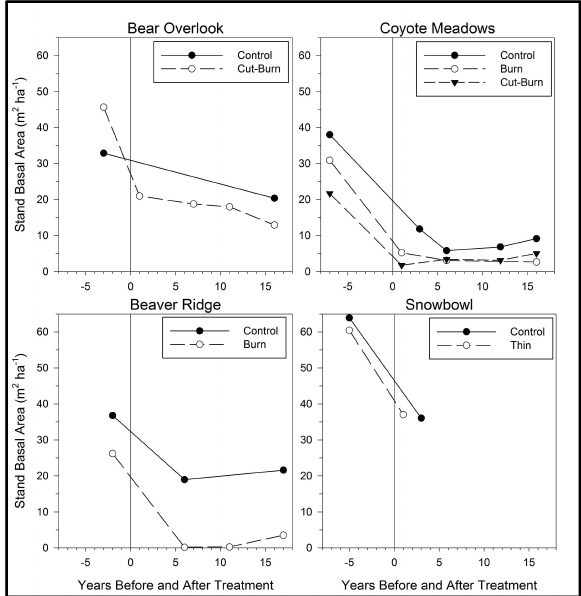
Figure 2. Changes in stand basal area (m 2 ha − 1 ; live trees above 11.3 cm diameter at breast height (DBH)) observed in the long-term monitoring plots across the four study sites (CM: Coyote Meadows; SB: Snowbowl; BO: Bear Overlook; BR: Beaver Ridge). The vertical line (year 0) indicates when treatment